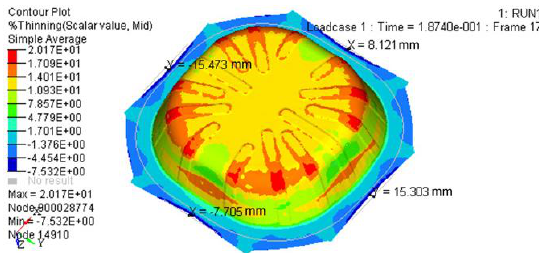
Figure 10. % Thinning distribution and X1, X2, Y1 and Y2 values for the RUN20; blank0.